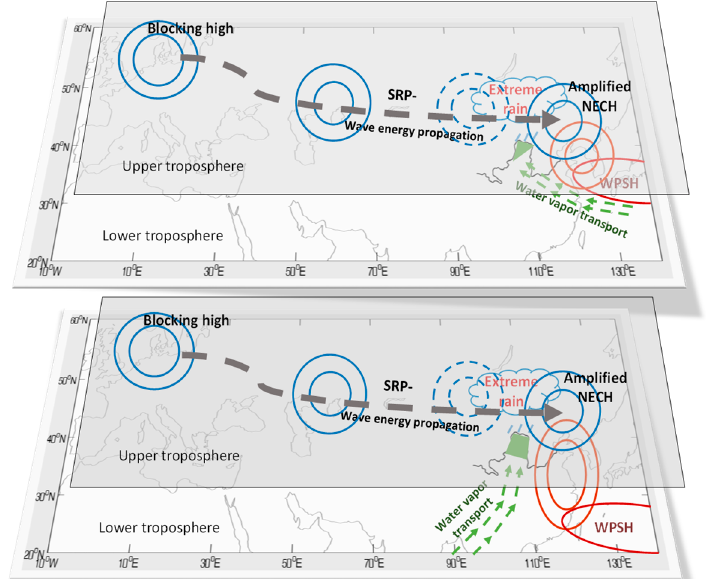
Figure 17. A schematic diagram showing how European blocking causes the occurrence of extreme precipitation over the YRLV under the combined action of the negative phase of the Silk Road pattern (SRP—the blue circles over mid-latitude Asia) and the western Pacific high (WPSH, the red solid arc). The Rossby wave energy (the thick dashed gray curve with arrows denoting the pattern and direction of the wave energy propagation) propagates in a southeastward direction from the European block to the SRP, amplifying the northeast China high (NECH), the eastern action center of the SRP in the upper troposphere. The lower troposphere anti-cyclonic circulation with a center over the Bohai Sea is the lower-level reflection of the NECH, which has a spatial pattern modulated by the location of the WPSH. The combined effect of the amplified NECH and the WPSH strengthens the water vapor transport and determines the water vapor transport pattern and location of extreme precipitation over the YRLV.